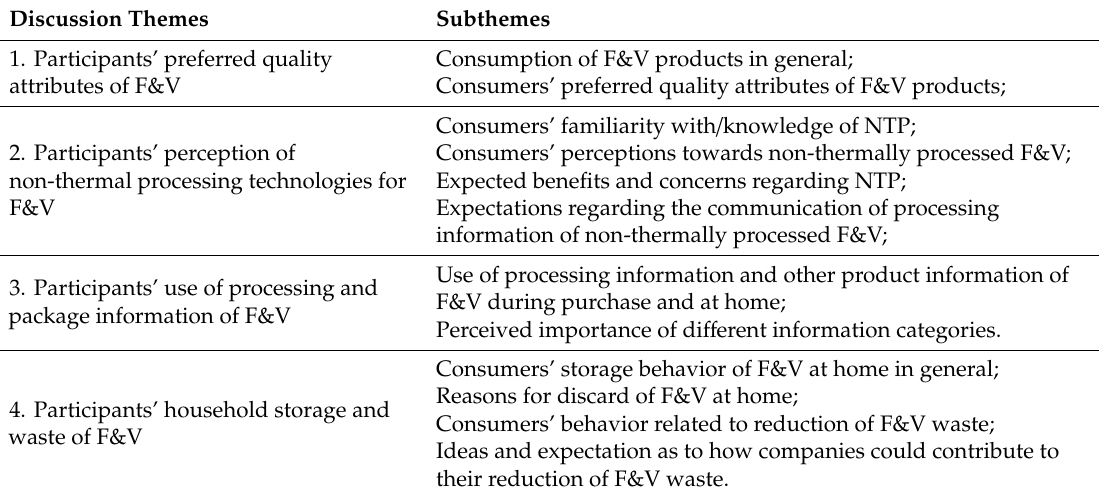
Table 2. Interview protocol for the focus